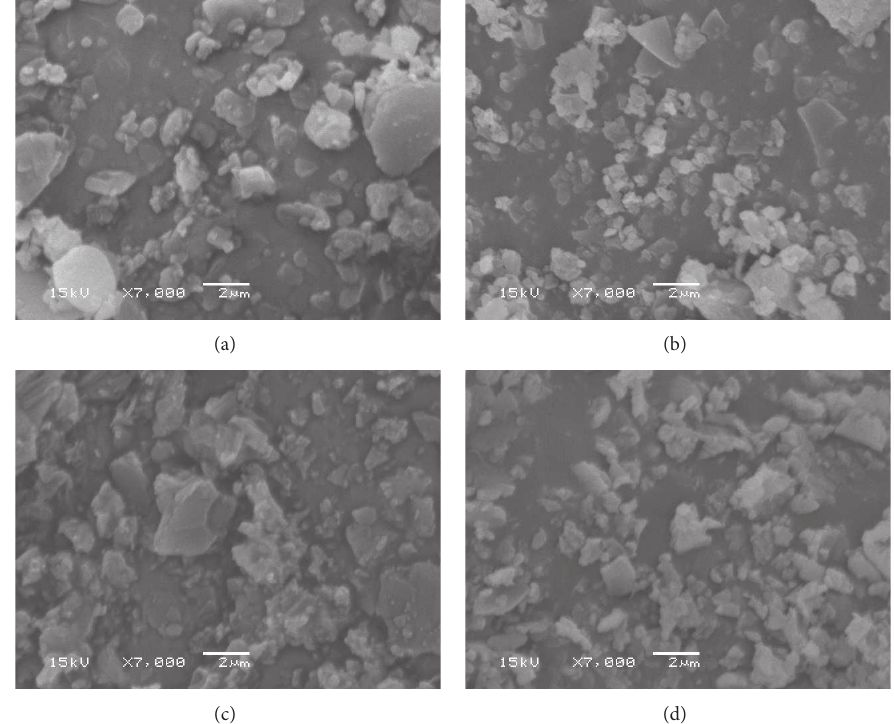
Figure 2: Photomicrographs of SEM of pure ET powder (a), pH shift method using PVP as a stabilizer (b), antisolvent method using PVP as a stabilizer (c), and pH shift method using Tween 80 as a stabilizer